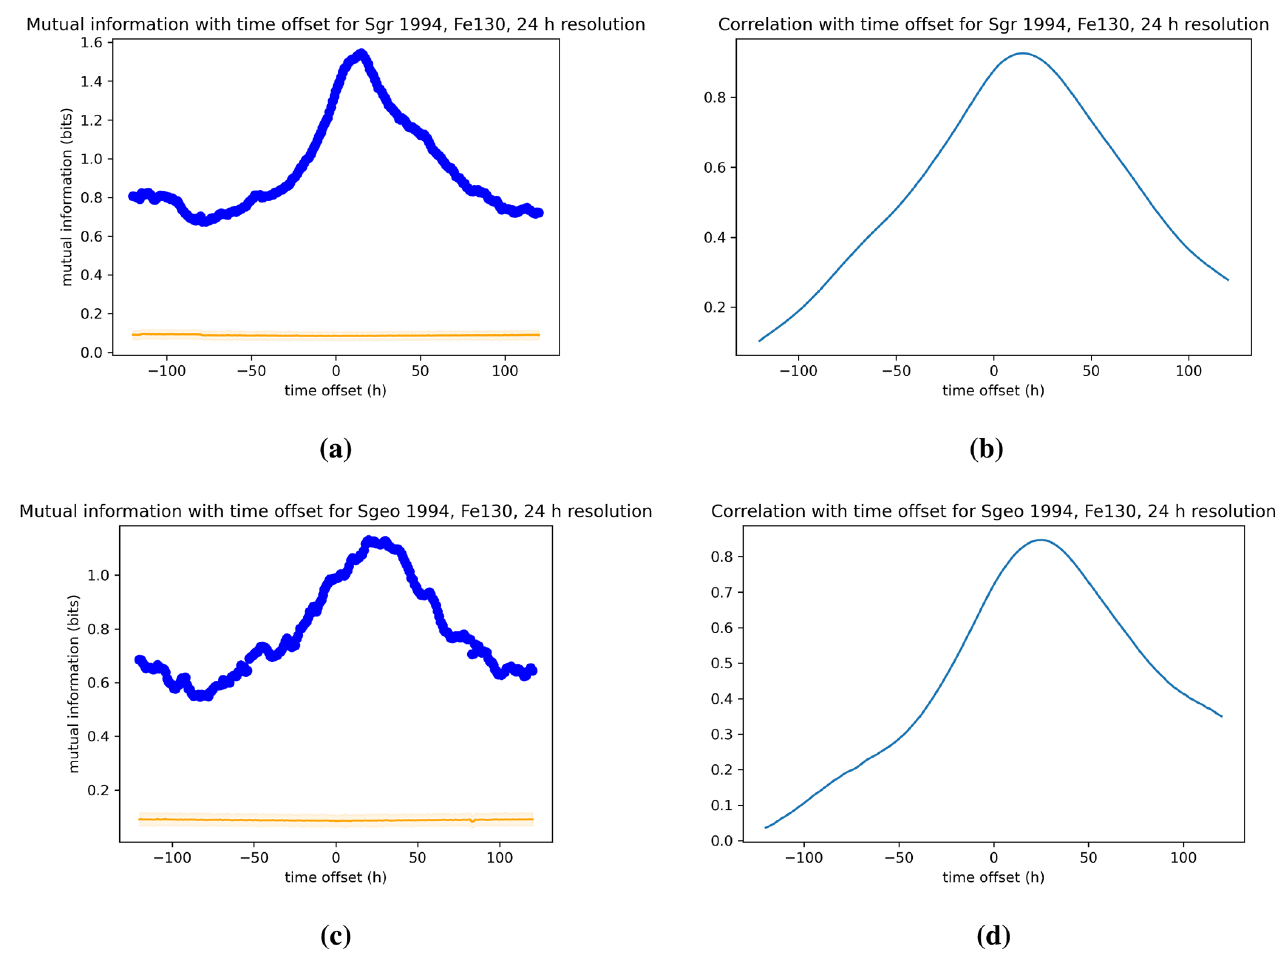
Figure 9. Same as in Fig. 8 but with a 24h moving average of each